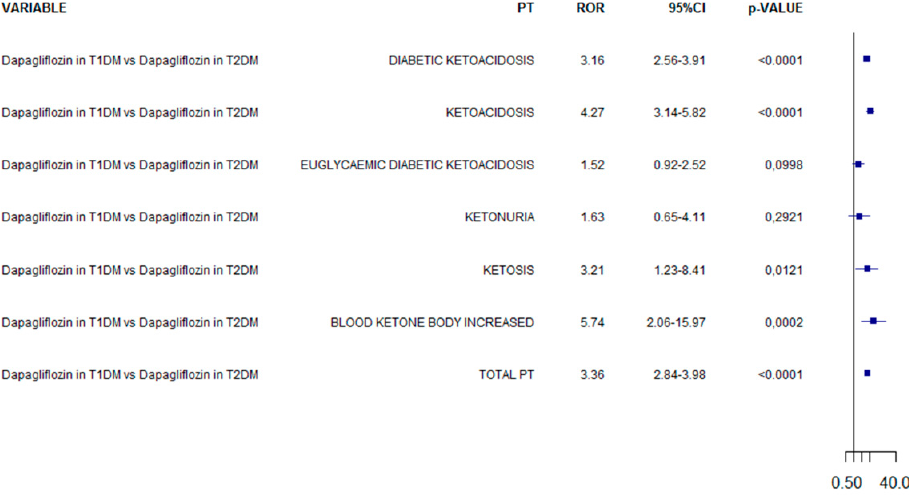
Figure 3. ROR of ketoacidosis adverse events for dapagliflozin in T1DM compared to dapagliflozin in T2DM.